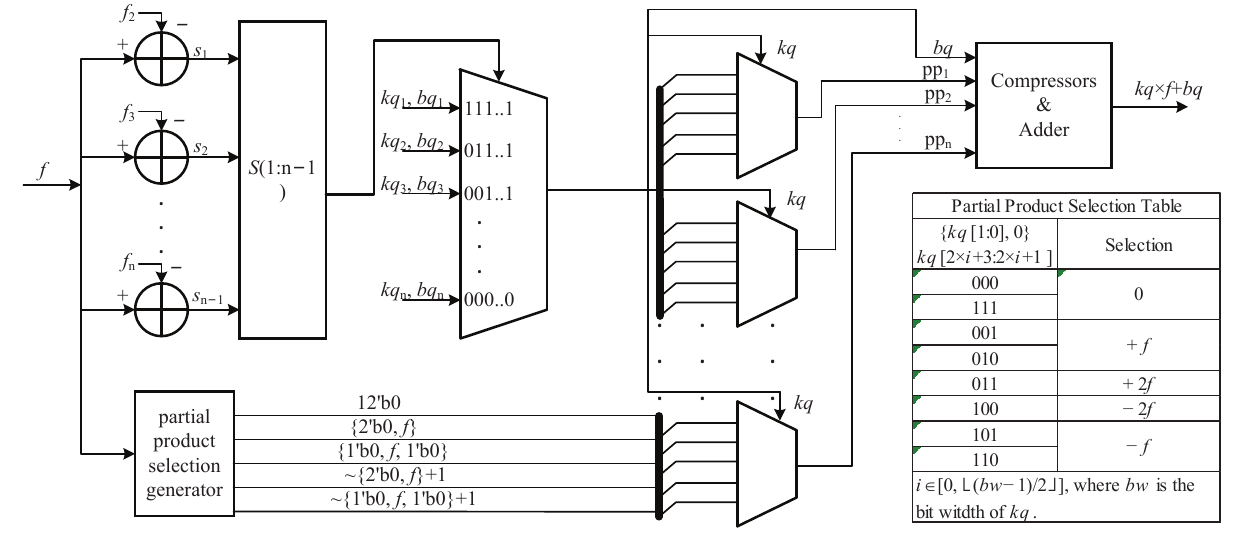
Figure 8. Proposed hardware architecture for the implementation of a single function. The symbols f 2 , f 3 and f n represent the starting points of the 2 nd , 3 rd and n th segments, respectively. The symbols s 1 to s n − 1 denote the signs of the outputs of the comparators. Table 2. Bit widths of bq and output in accordance with the selected values of sw in Table 1.